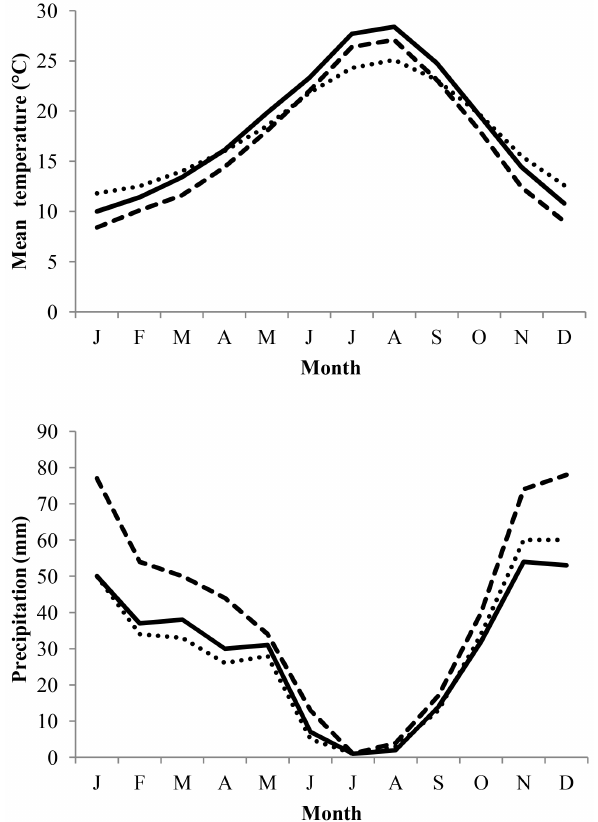
Figure 1. Climatic data on the regions of Mostaganem (dotted line), Relizane (full line), and Mascara (dashed line) obtained from the website